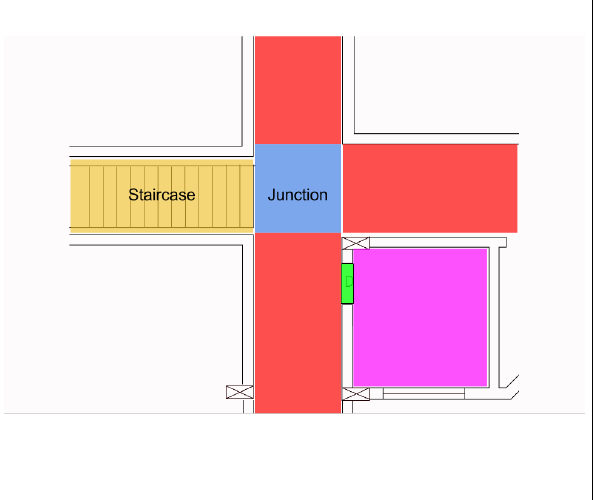
Figure 4: Spaces marked as staircase(yellow), junction(blue), room(pink), corridor(red) and doors/windows(green)